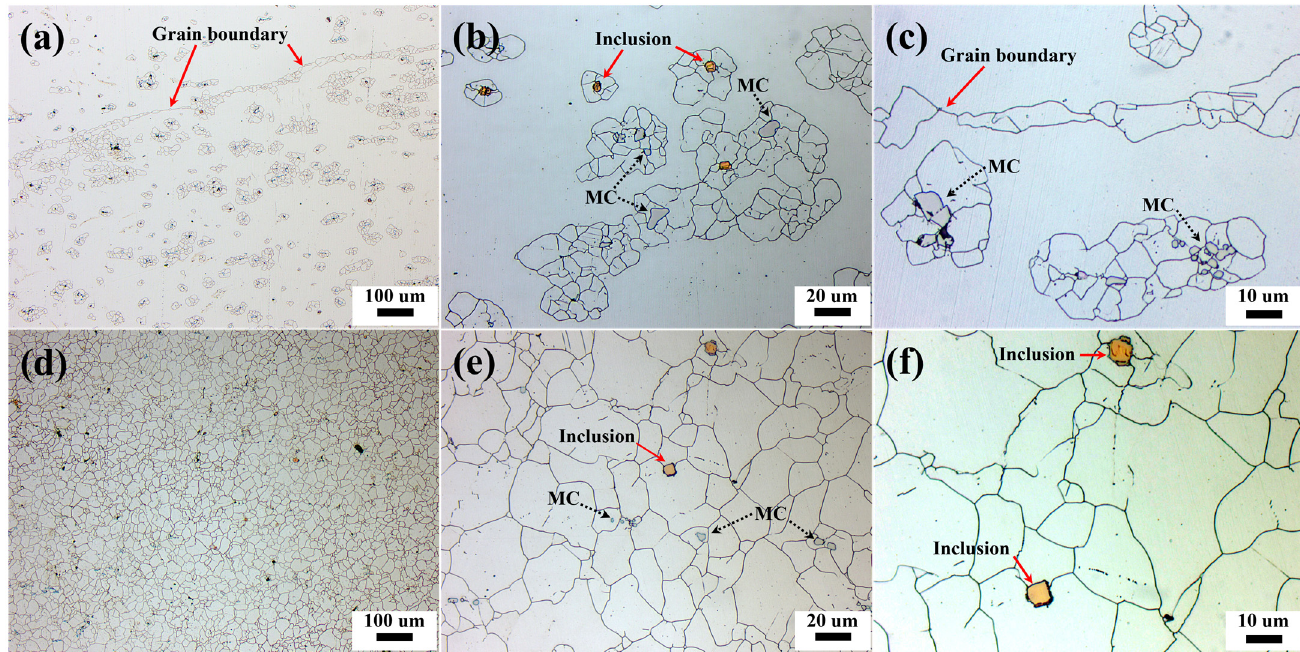
Figure 9. Untwinned grains of as-forged GH4169 by OM after etching with etchants 3 and 4: 10% deformation: ( a ) 100×, ( b ) 500×, ( c ) 1000×; 80% deformation: ( d ) 100×, ( e ) 500×, ( f ) 1000×.